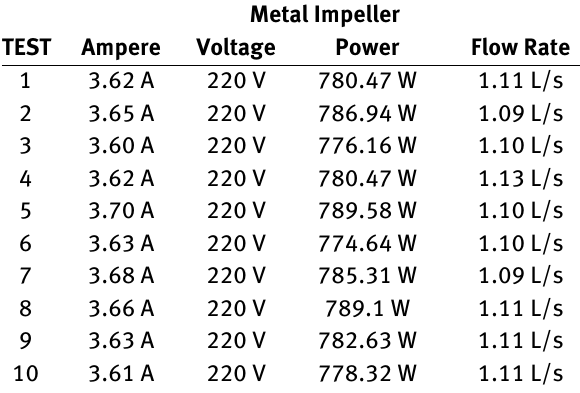
Table 2: Testing the Pump using Metal Impeller Metal Impeller